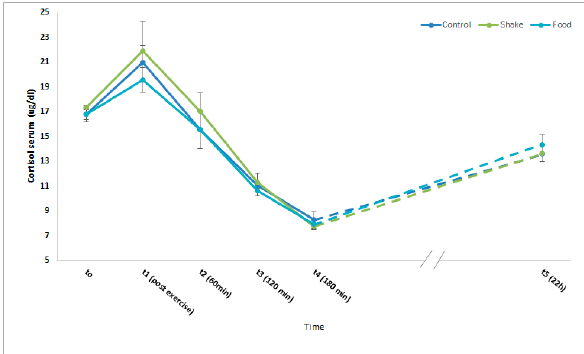
Figure 3. Effects of protein/carbohydrate uptake via food or shake, immediately after exercise, on serum cortisol concentrations. Mean serum cortisol concentrations of all participants. Mean ± SD. p ≤ 0.05 show statistically significant differences between marked group and respective t0 value.